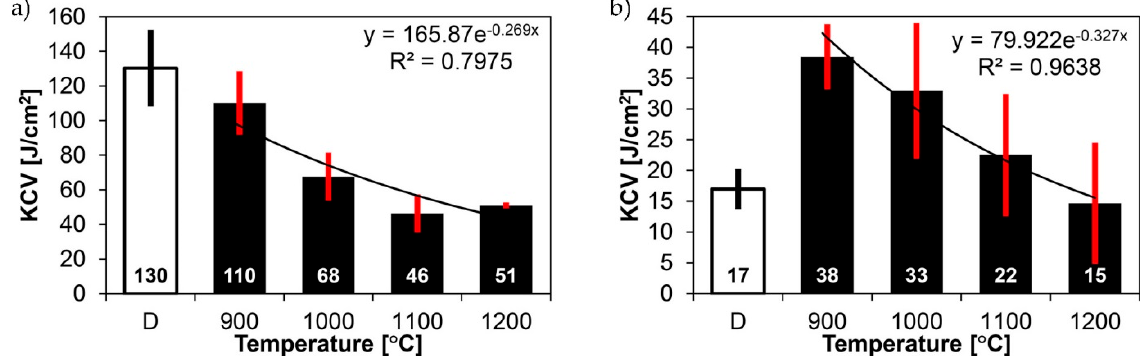
Figure 21. Impact test results of welded joints of Hardox 450 steel in the delivery state and after quenching from austenitising temperature in the range of 900–1200 °C: ( a ) test temperature +20 °C, ( b ) test temperature − 40 °C. D—delivery state (directly after welding).